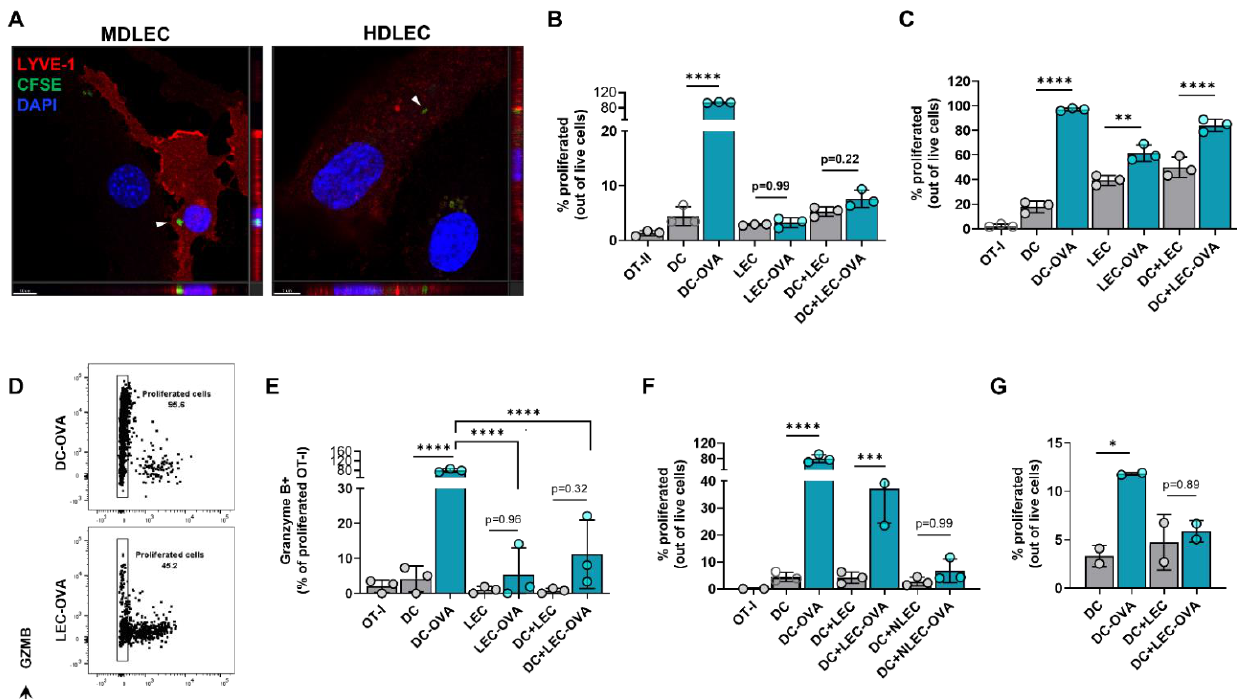
Figure 7. Cultured LECs engulf tumor debris and induce CD8+ T cell proliferation with reduced effector function. ( A ) Representative confocal micrograph including Z-plane of CFSE-labeled B16F10 tumor debris (arrows) within cultured mouse dermal LECs (MDLEC) and human dermal LECs (HDLEC). Scale bars; left, 10 µ m; right, 7 µ m. ( B ) CD4+ OT-II and ( C ) CD8+ OT-I proliferation after co/tri-culture conditions with the indicated cell types in the presence of LEC or DC unpulsed or pulsed with OVA protein (2 mg/mL) 24 h prior to co/tri-culture. ( D ) Representative FACS plot and ( E ) quantification of GZMb+ proliferated OT-I cells after culture with indicated cell types in the presence of LEC or DC either unpulsed or pulsed with OVA protein (2 mg/mL) 24 h prior to co/tri-culture. ( F ) OT-I proliferation after co/tri-culture with indicated cell types either NH 4 -Cl pretreated or not for 24 h followed by pulsing or no pulsing with OVA protein (2 mg/mL) 24 h prior to co/tri- culture. ( G ) OT-I proliferation after culture with indicated cells pulsed or not pulsed with OVA protein (2 mg/mL) at 4 °C 24 h prior co/tri-culture. Statistical significance assessed using one-way ANOVA on data from at least 3 biological replicates (B-G); DC-OVA, OVA pulsed DC; LEC-OVA, OVA pulsed LEC; NLEC, NH 4 -Cl pretreated LEC; NLEC-OVA, OVA pulsed NH 4 -Cl pretreated LEC..Error represented as SD. *, p < 0.05; **, p < 0.01; ***, p < 0.001; ****, p < 0.0001.